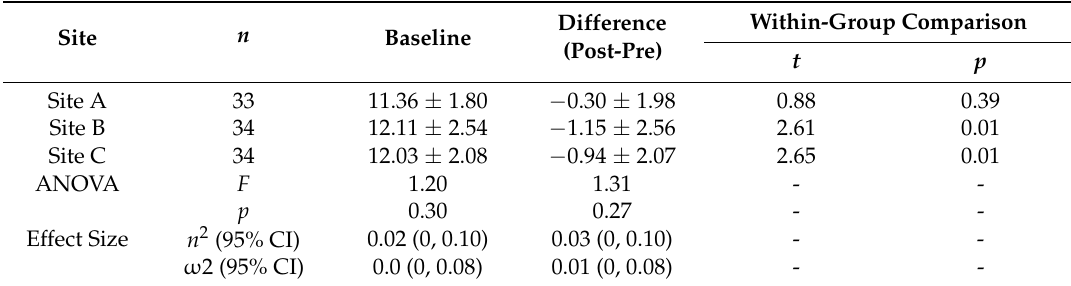
Table 6. Pre- and post-visit comparison of levels of tension across the three sites ( n = 101). Site